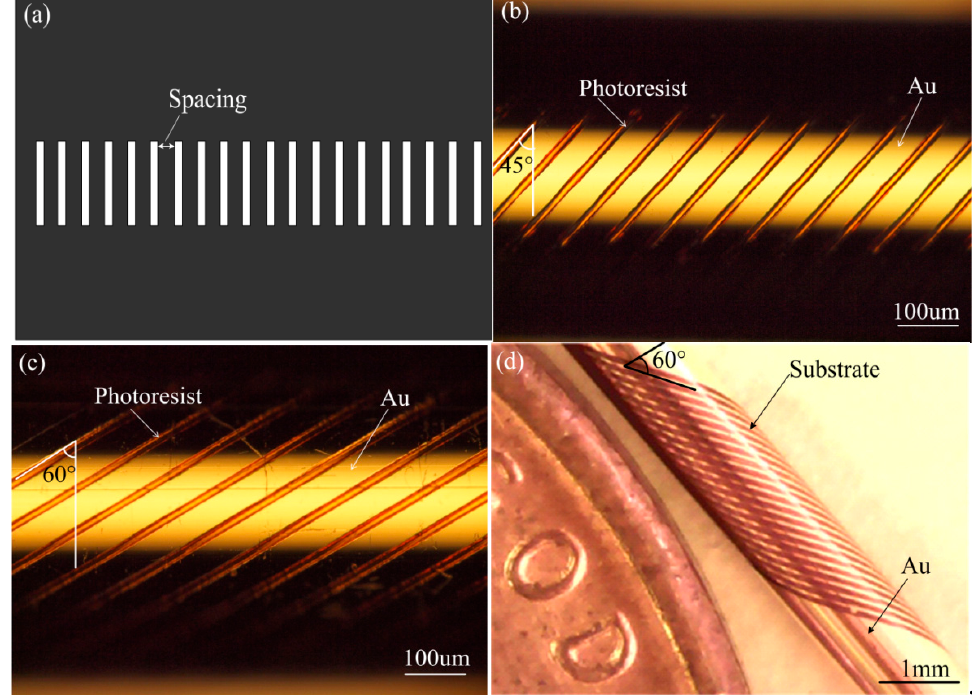
Figure 8. Mask pattern and tilt microcoil pattern. ( a ) Mask pattern with multi-lines; ( b ) Optical image of fabricated microcoil with 45° tilt-angle; ( c ) Optical image of the fabricated microcoil with 60° tilt-angle; ( d ) Photography of 20 turn microcoil with 60° tilt-angle fabricated on the 1 mm diameter ployimide capillary substrate.